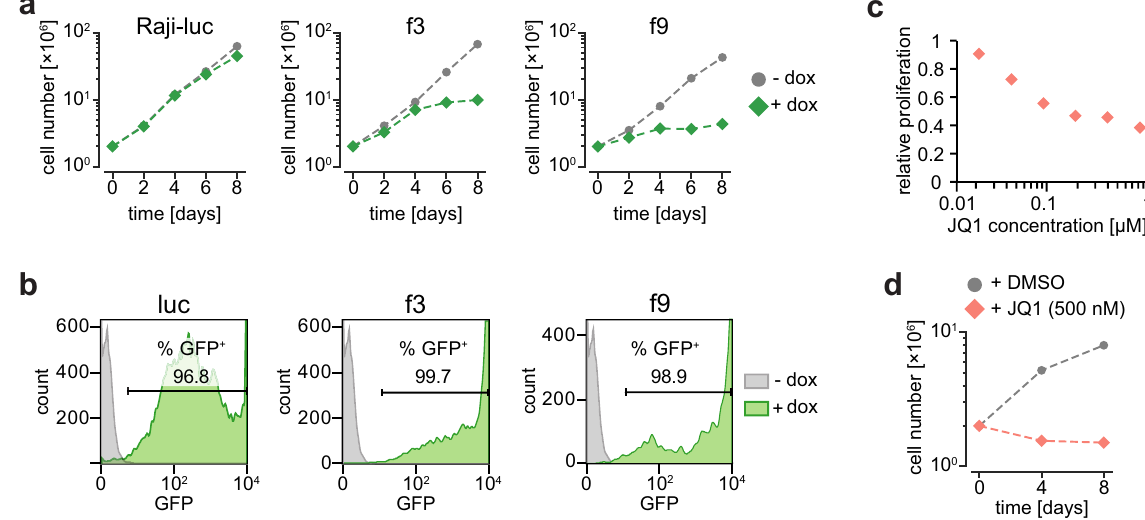
Figure 2. Proliferation assay of Raji cells expressing f3 and f9 or after treatment with JQ1. ( a ) Non-induced (gray) and induced cells (25 ng/ml doxycycline, green) were plotted. Induced cells expressed either luciferase (Raji-luc, negative control) or dominant-negative Brd4 mutants f3 and f9. ( b ) Percentage of induced cells (green) were assessed by measuring GFP reporter signals using flow cytometry. Uninduced Raji f2 cells served as negative control (gray). ( c ) Raji cells were treated with increasing concentrations of JQ1 for 72 hours. Cell proliferation was measured via MTS assay and plotted against JQ1 concentration (log scale). ( d ) Induced Raji- luc cells were treated with 500 nM JQ1 (red)/DMSO (gray, control) for 8 days. Living cell numbers were counted and plotted against